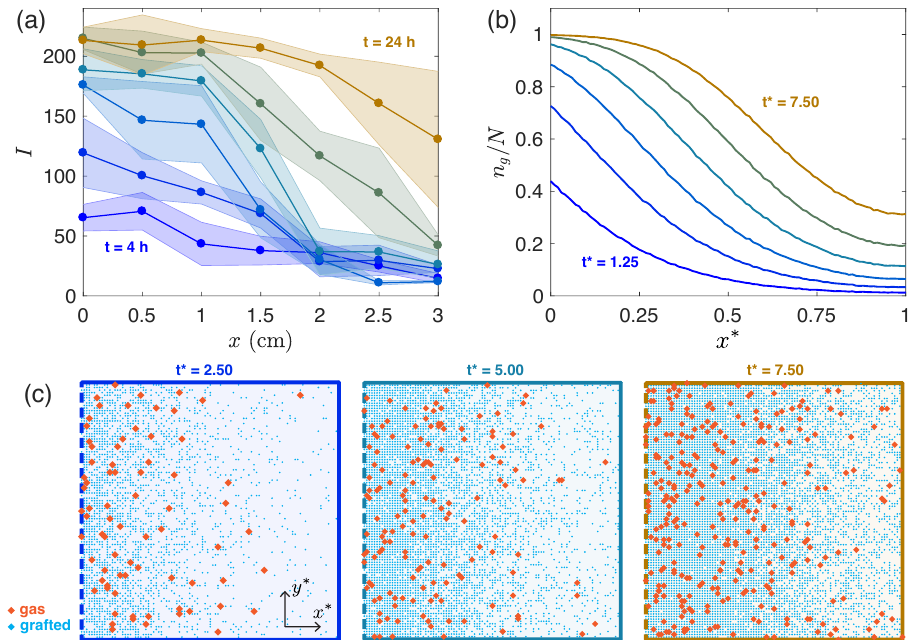
Figure 3. ( a ) Experimental measurements of fluorescent intensity profile at 6 different times, separated by 4 h. Interior secondary chamber dimensions: L × w × h = 30 × 30 × 1 mm. Five images are taken at 5 mm increments and five randomly selected points within each of these images is measured for average fluorescence intensity. Shaded regions on each side represent one standard deviation of measurements obtained from at least three independent experiments. ( b ) Prediction of model at six evenly spaced times (for t ∗ > τ ∗ x ) with P g = 5 × 10 − 4 , L ∗ = 1, w ∗ = 1, h ∗ = 0.03, ˙ m ∗ = 1000. Each curve for t ∗ = 1.25, 2.50, 3.75, 5.00, 6.25, and 7.50, represents the average result over 500 runs. ( c ) Views of vaporized (orange) and grafted (blue) silane particle locations within a single simulation for times t ∗ = 2.50, 5.00, and 7.50 (left to